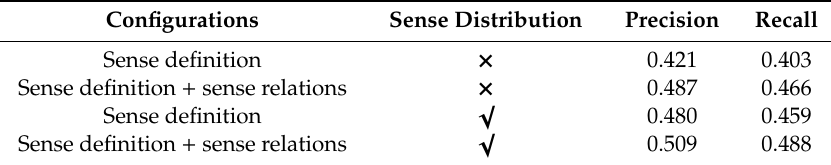
Table 3. The results with and without sense relationships / sense distribution.